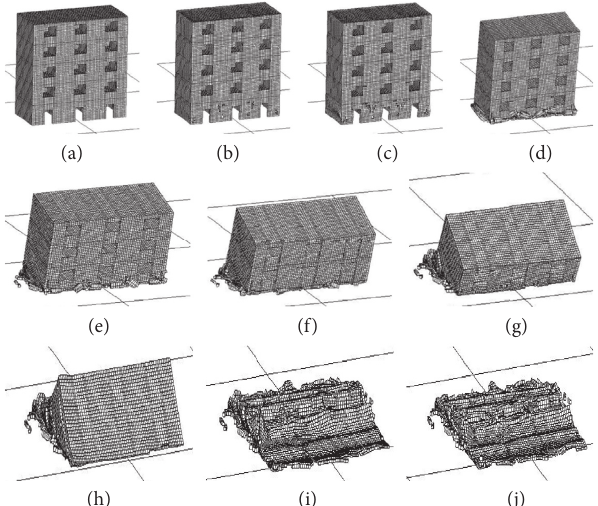
Figure 8: Collapse process of the five-story masonry structure under the 3rd working condition. (a) t � 0s, (b) t � 1.51s, (c) t � 1.85s,